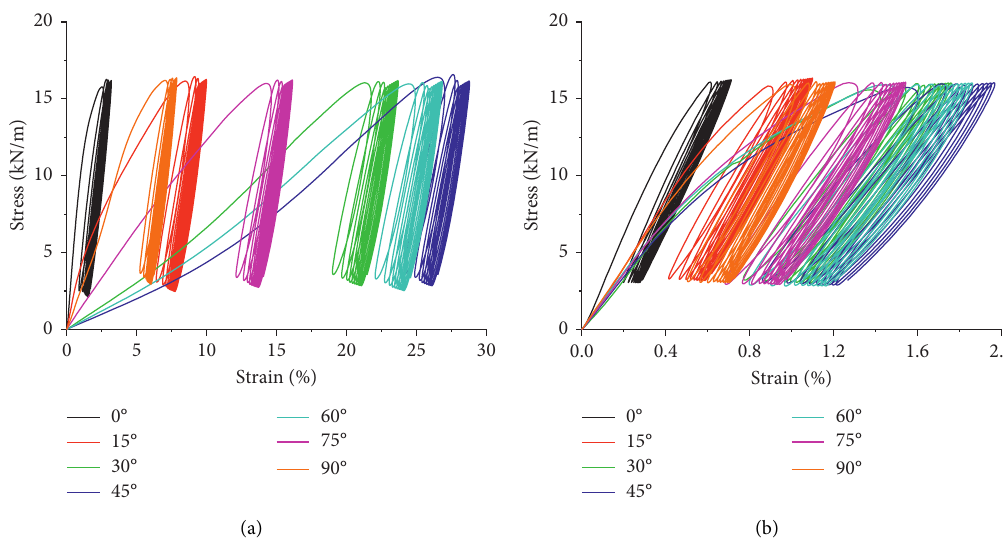
Figure 16: Cyclic tensile stress-strain curve. (a) PVC membrane material. (b) PV-PVC composite.